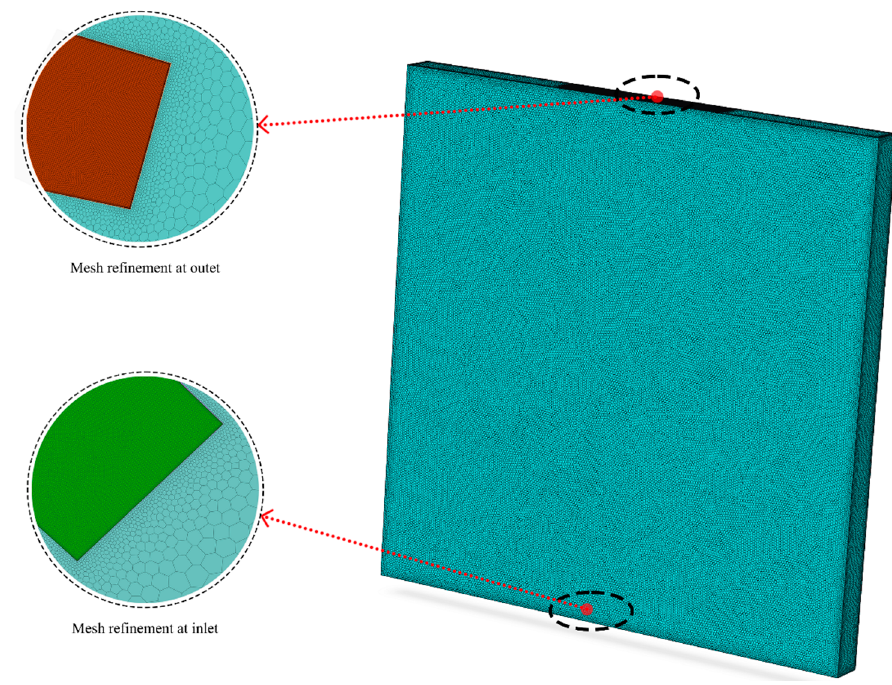
Figure 3. The meshing of the physical model.